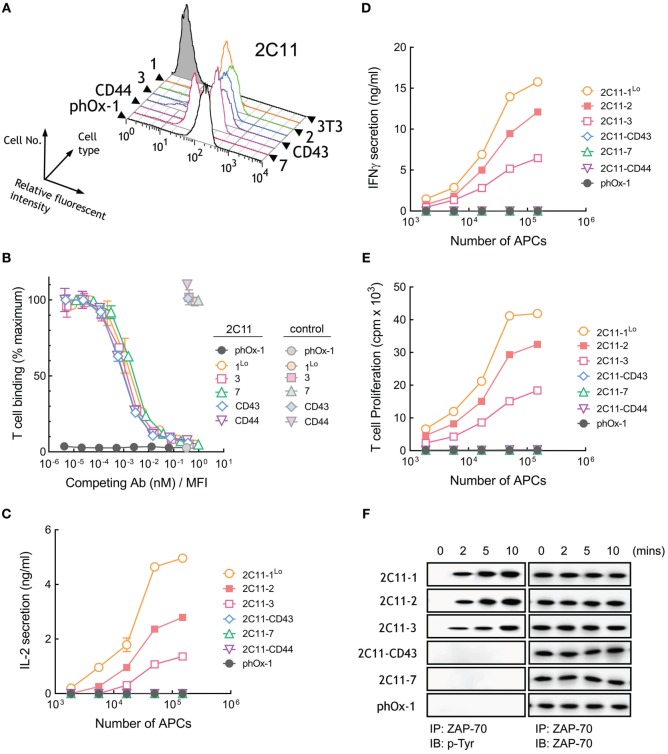
Membrane-tethered 2C11 scFv activate T cells in a dimension-dependent manner. (A) Surface expression of membrane-tethered 2C11 scFv on 3T3 cells was measured by FACS. (B) Calcein-AM-labeled naive mouse T cells were incubated with monolayers of 3T3 cells expressing membrane-tethered 2C11 scFv in the presence of serial dilutions of 2C11 IgG (dark symbols) or 10 µg/ml negative control IgG (light symbols). Unbound T cells were washed away and cellular fluorescence of the remaining bound cells was measured (n = 3). The y-axis shows the mean fluorescence of bound T cells, whereas the x-axis represents the concentration of soluble 2C11 IgG added normalized for the level of each membrane-tethered 2C11 scFv, as determined by mean immunofluorescence intensity of the 3T3 antigen-presenting cells (APCs) stained with anti-HA antibody. Bars, SD. (C) 5 × 104 naïve mouse T cells were incubated with the indicated numbers of 2C11 APCs or control phOx-1 APCs for 24 h before measuring IL-2 (C) and IFN-γ (D) in the culture medium or the proliferation (E) of the T cells as assessed by the incorporation of 3H-thymidine (n = 3). Bars, SD. (F) 107 B3Z cells were incubated with 106 2C11 APCs or control phOx-1 APCs for the indicated times before ZAP-70 was immunoprecipitated from cell lysates. Total ZAP-70 (right panel) or phosphorylated ZAP-70 (left panel) levels were determined by immunoblotting with anti-ZAP-70 or anti-phosphotyrosine antibodies, respectively.